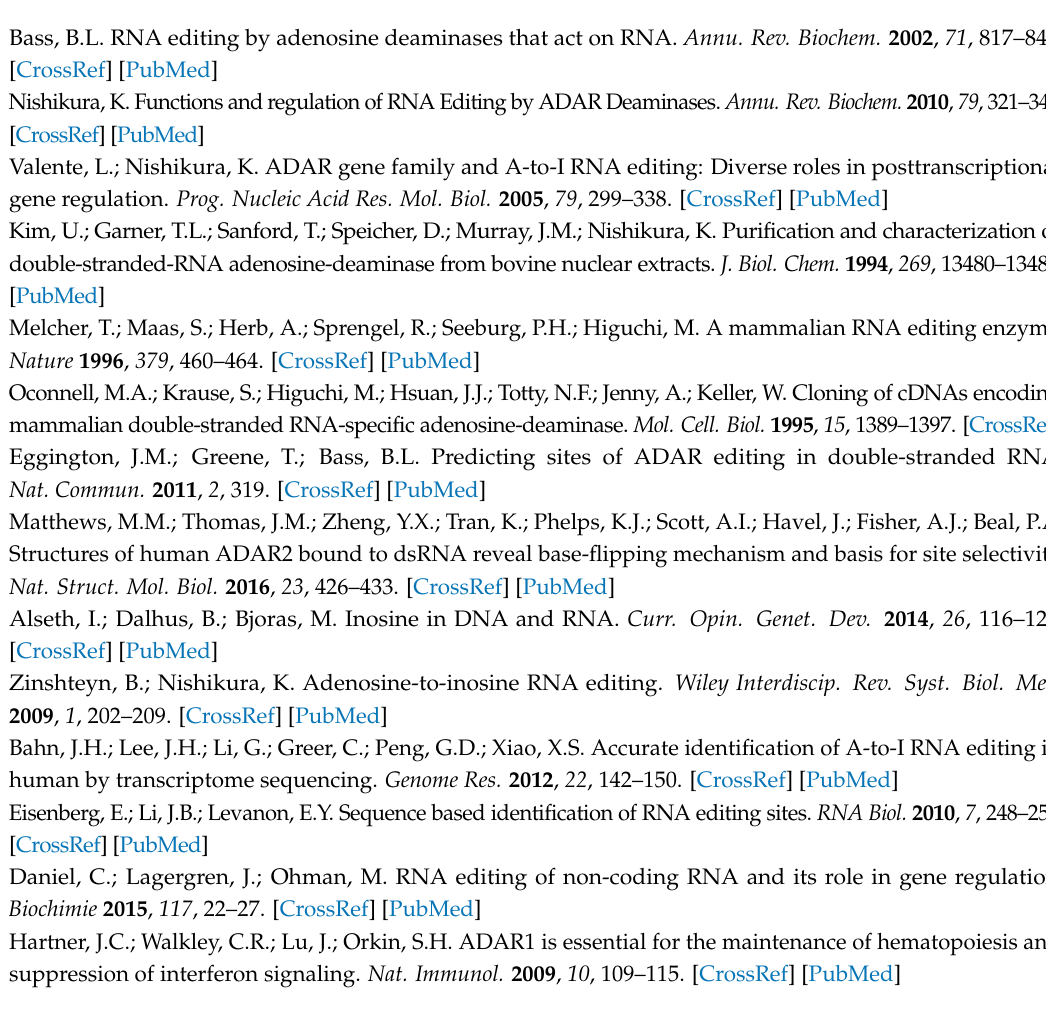
in the single I–U systems as a result of correlation between N1(I)–O2(U) and O6(I)–N3(U) H-bond distances. Figure S3: RMS deviations along the production trajectories evaluated for the tandem I–U/I–U systems. Figure S4: Distribution of various geometries of the first I–U base pair observed in the I–U/I–U tandem systems as a result of correlation between N1(I)–O2(U) and O6(I)–N3(U) H-bond distances. Figure S5: Selected structures from molecular dynamics (MD) simulations. Figure S6: Energetic profiles of A–U and single I–U pairs based on in the ABF simulations. Table S1: Two-term coefficients describing editing frequencies by ADAR1 and ADAR2 based on experimental study. Table S2: Averaged local bend values calculated for twelve selected